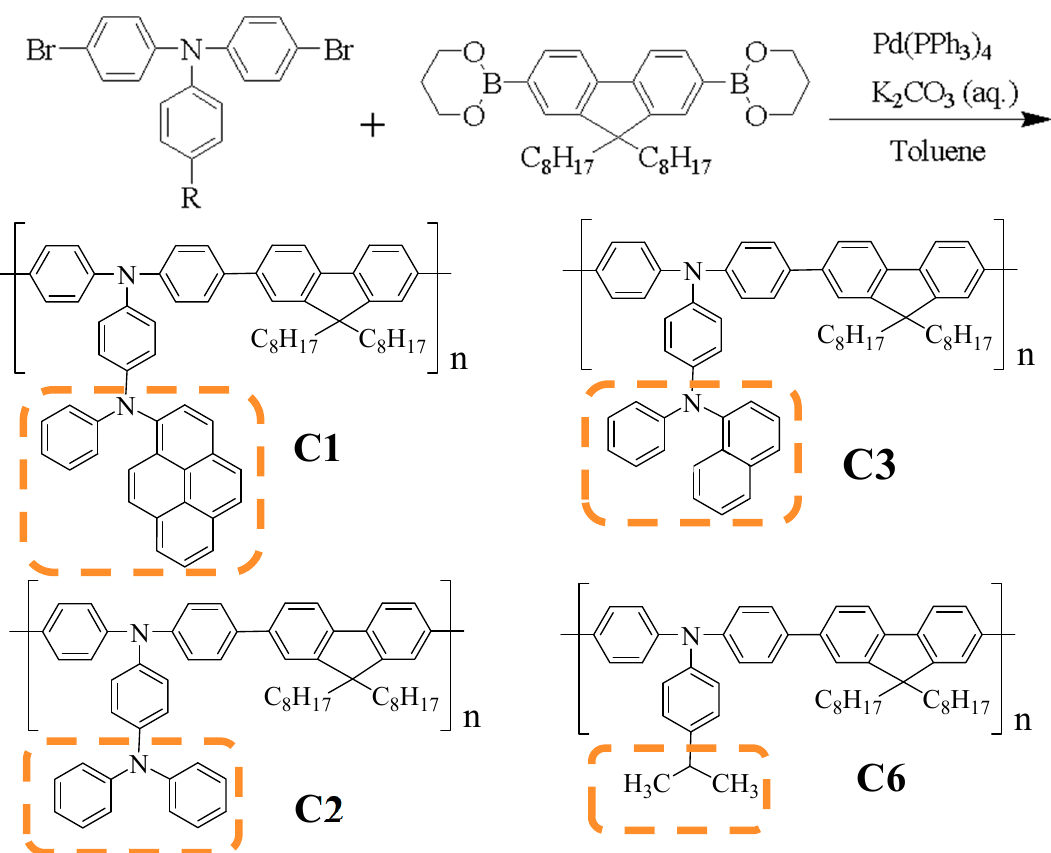
Figure 2. Polymers C1, C2, C3, and C6 are synthesized via the Suzuki coupling method. Table 1. Electrochemical Properties of the Conjugated Polymers C1, C2, C3, and C6.